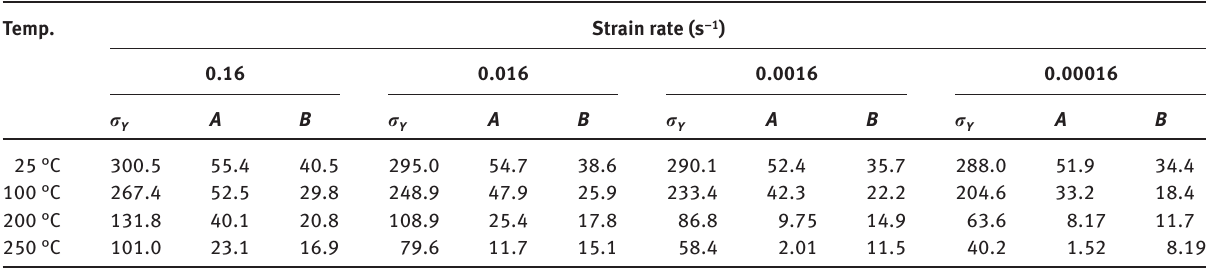
Table 2: Hardening parameters at elevated temperatures and strain rates determined by fitting curves